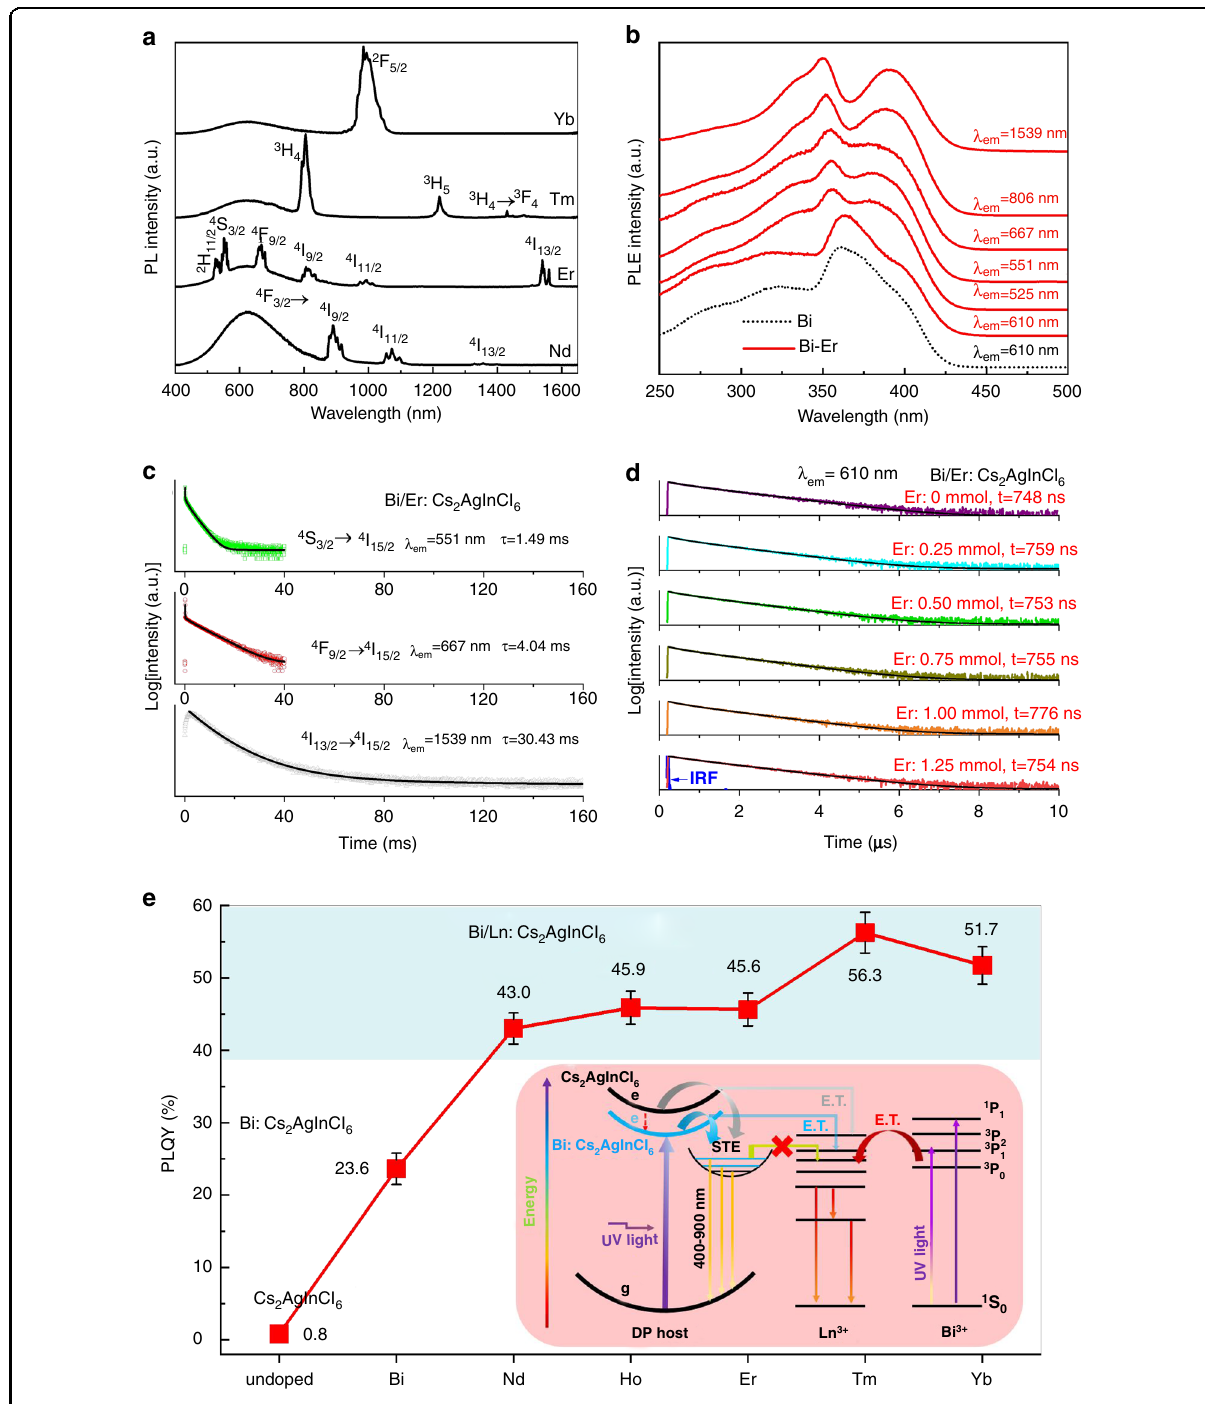
Fig. 2 Spectroscopic characterization and energy-transfer processes in Bi/Ln:Cs 2 AgInCl 6 DPs. a PL spectra of the Bi/Ln (Ln = Nb, Er, Tm, and Yb): Cs 2 AgInCl 6 samples. b PLE spectra of the Bi:Cs 2 AgInCl 6 and Bi/Er:Cs 2 AgInCl 6 samples obtained by monitoring different emitting wavelengths. PL decay curves obtained by monitoring ( c ) Er 3 + emissions and ( d ) STE recombination in the Bi/Er:Cs 2 AgInCl 6 samples. IRF represents the instrumental response function. e PLQYs for a series of the Bi/Ln:DPs. The inset shows the proposed energy-transfer mechanisms and emission processes involving both STE recombination and Ln 3 + 4f – 4f